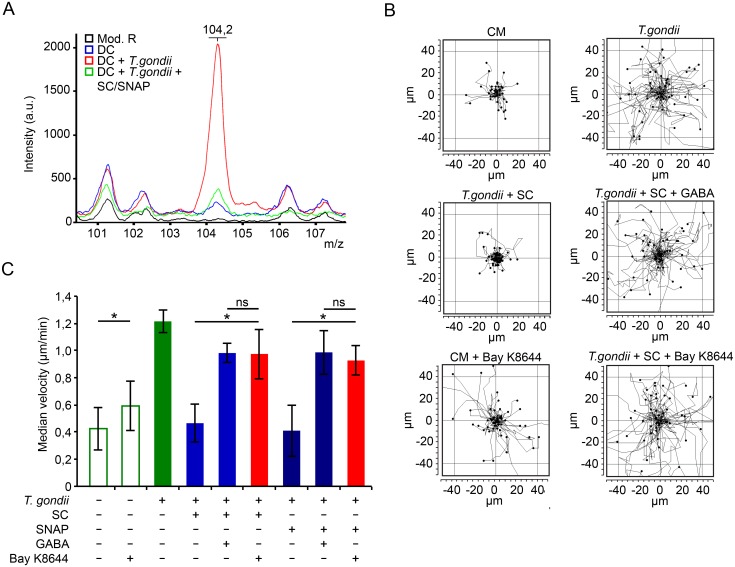
Exogenous GABA and Ca2+ receptor agonism reconstitutes DC hypermotility.(A) Mass spectrometry analysis of DCs challenged with tachyzoites (PRU, MOI 3) for 16 h ± GABAergic inhibition (SC, 50 μM; SNAP, 50 μM). Cell supernatant was analyzed as indicated under Materials and Methods. Mod. R indicates modified Krebs-Ringer’s solution. Data are representative of 3 independent experiments. (B) Representative motility plot analyses of DCs incubated with tachyzoites (PTG, MOI 3) for 2 h with SC (50 μM), SNAP (50 μM), ± GABA (5 μM) or Bay K8644 (10 μM). (C) Compiled motility analysis of DCs under same conditions as in (B). Motility assays were performed as described under Materials and Methods. Data represent median velocities ± SD of 3 independent experiments. Asterisks indicate significant differences (*: p < 0.01, ns: p ≥ 0.05, Pairwise Wilcoxon rank-sum test, Holm correction).